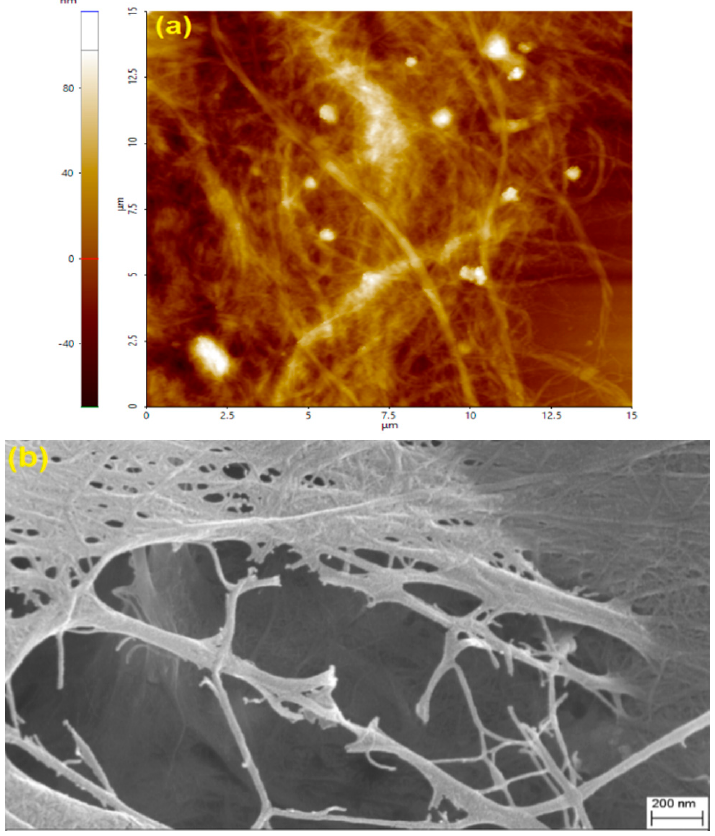
Figure 3. ( a ) Atomic force micrograph (height image) and ( b ) Scanning electron microscope image of pure CNFs.